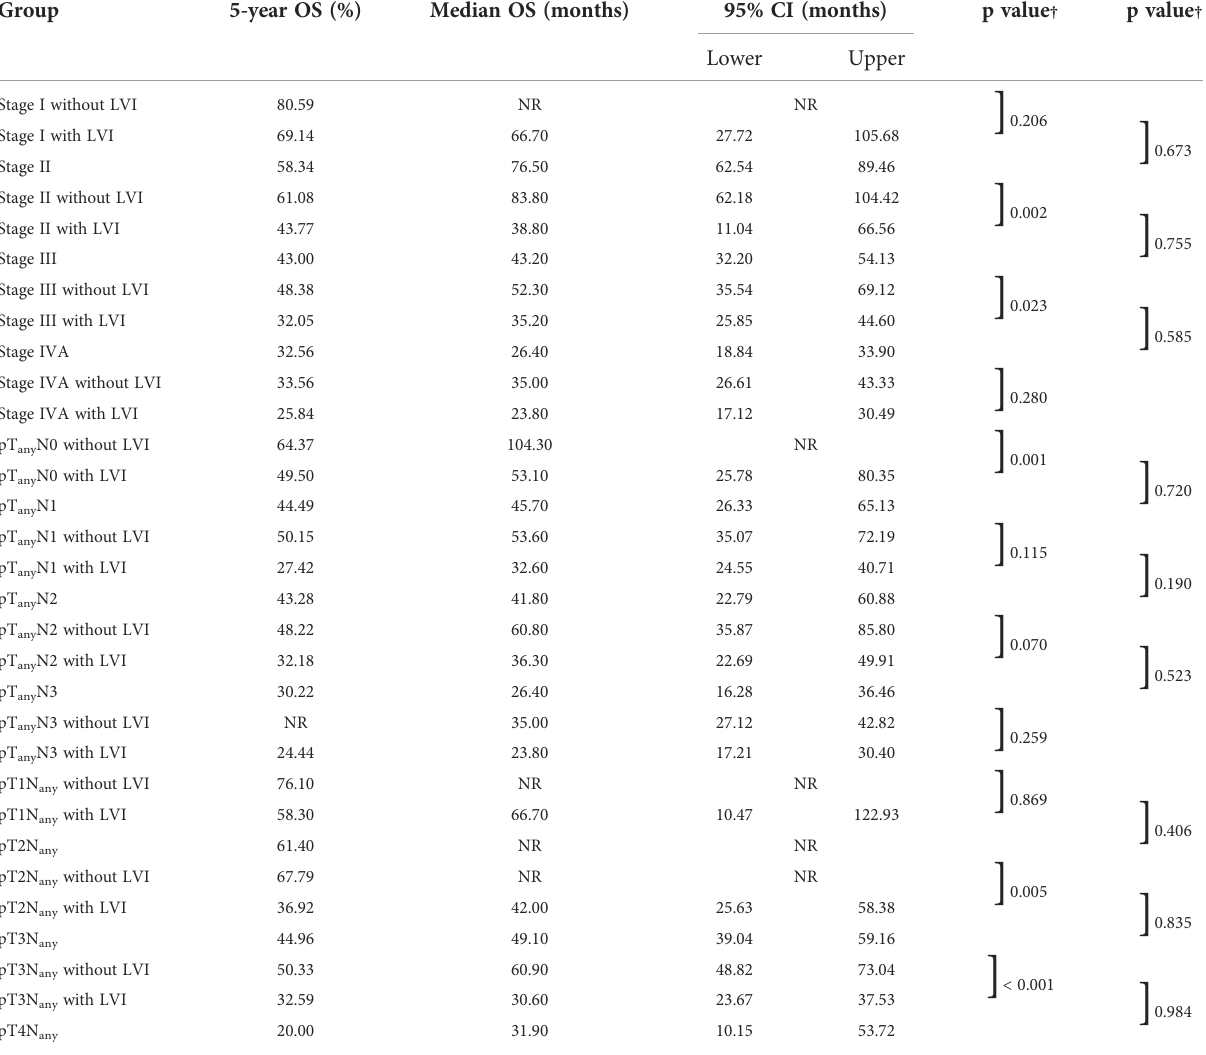
TABLE 3 Subgroup analysis of overall survival strati fi ed by lymphovascular invasion, pathological stages, N classi fi cations and T classi fi cations.